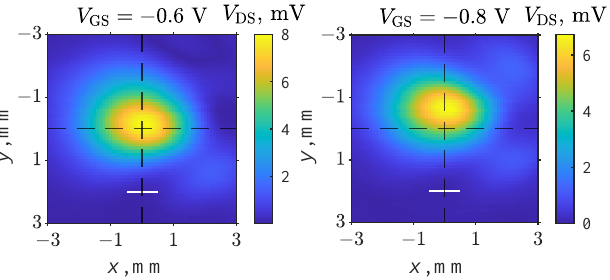
Figure 6. Focused 0.307 THz beam profile images obtained at V GS = 0.6 V and V GS = 0.8 V voltages applied to the CE3521M4 transistor. One-wavelength-long white lines are shown for easier